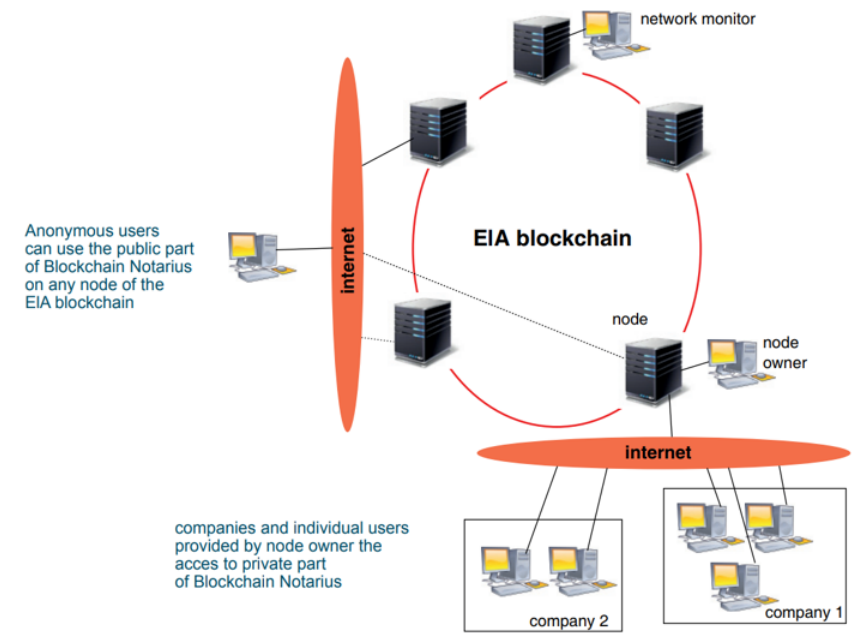
Figure 3: Blockchain Notarius structure³